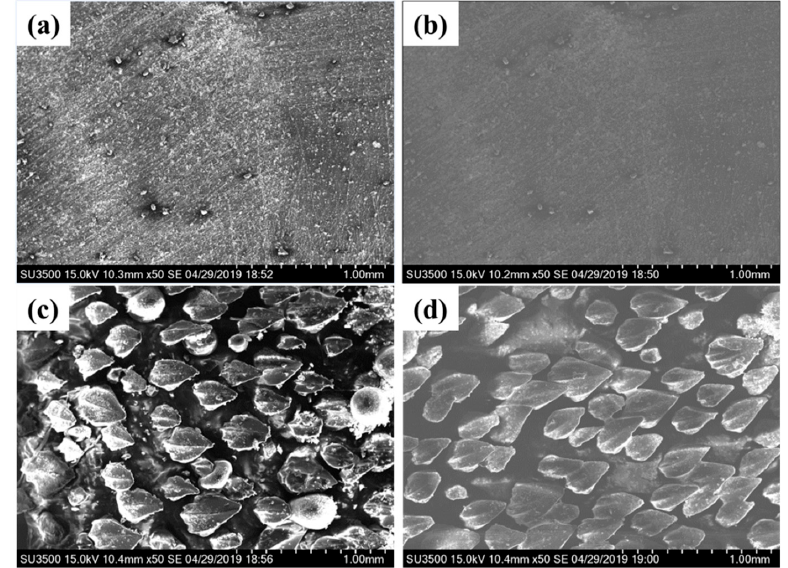
Figure 10. SEM of surfaces after abrasion with sand paper: ( a ) flat sample, ( b ) LS sample, ( c ) BS sample, and ( d ) BSLS sample.